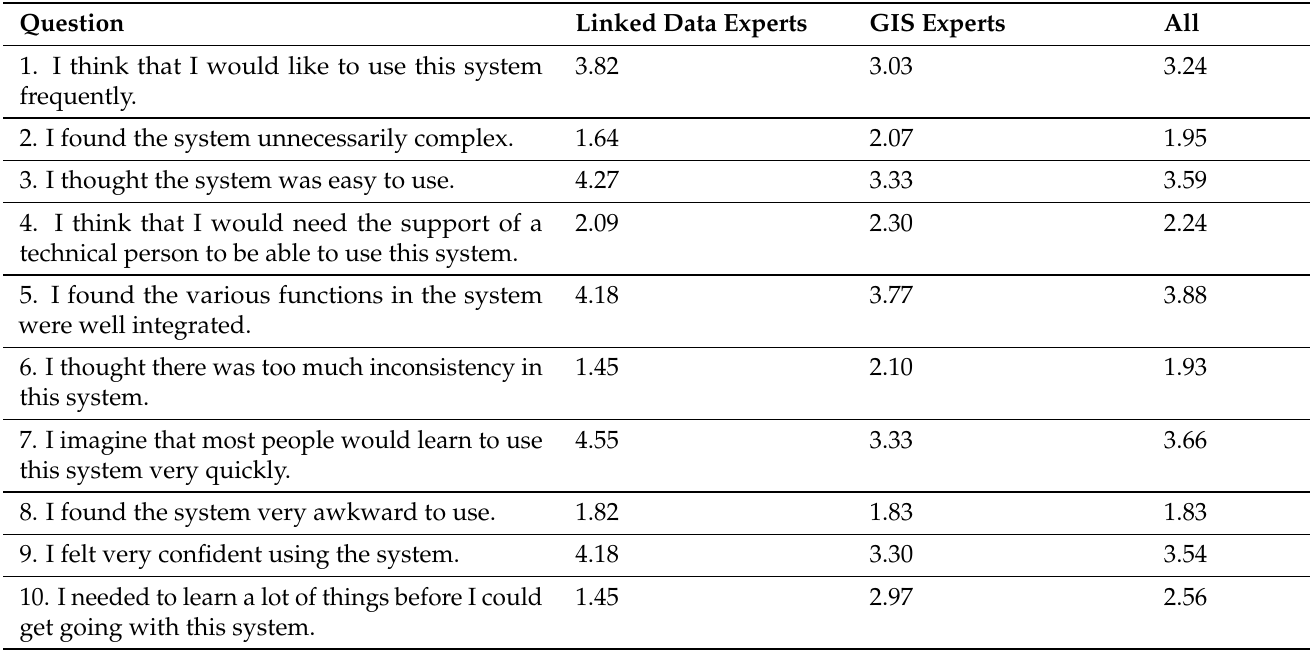
Table 8. Standard Usability Scale (SUS) questionnaire results per question in the scale 1 (Strongly disagree) to 5 (Strongly agree).